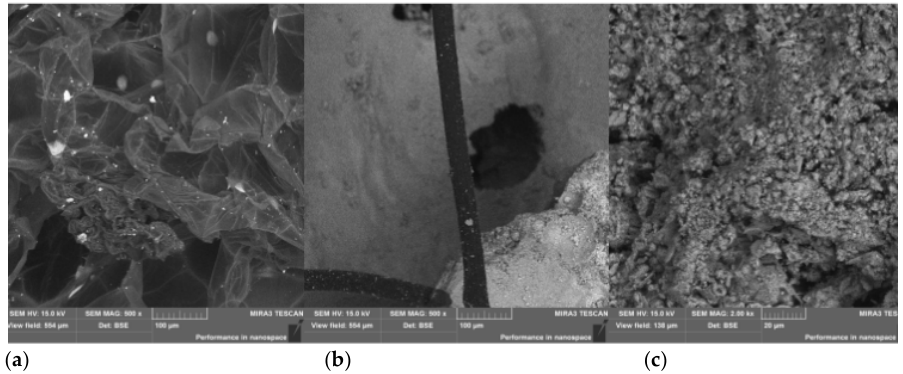
Figure 4. Microstructure of constituent components of polystyrene concrete: ( a ) polystyrene, ( b ) fiber, and ( c ) binder.